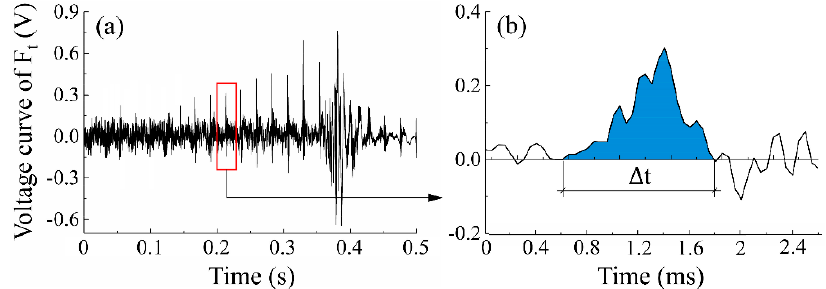
Figure 3. The integration processing of the voltage curve of tangential force F t : ( a ) a typical voltage curve of F t covering several scratches, and ( b ) an extracted voltage curve of F t for a single scratch.